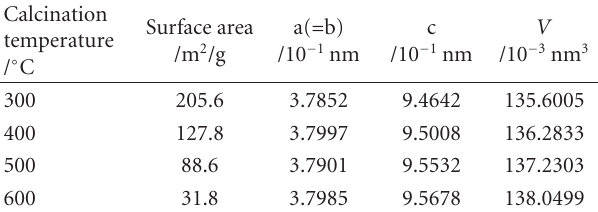
Table 1: Lattice parameters and BET surface areas of 3% B-TiO 2 samples calcinated at di ff erent